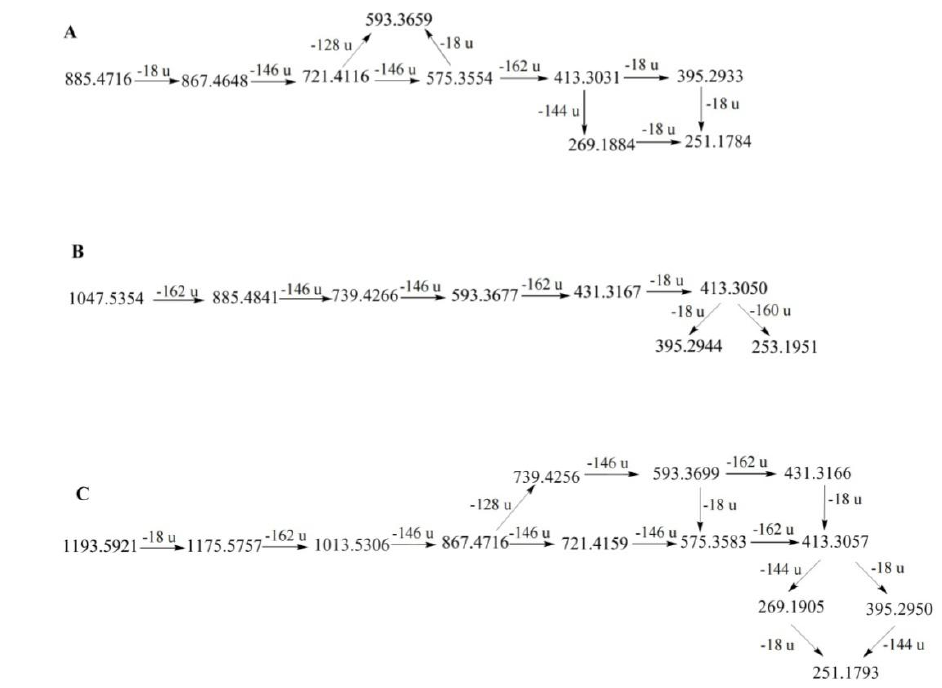
Figure 4. The fragmentation pathways of compounds 64 ( A ), 40 ( B ), and 36 ( C ) in positive ion mode [23,26,29–31].